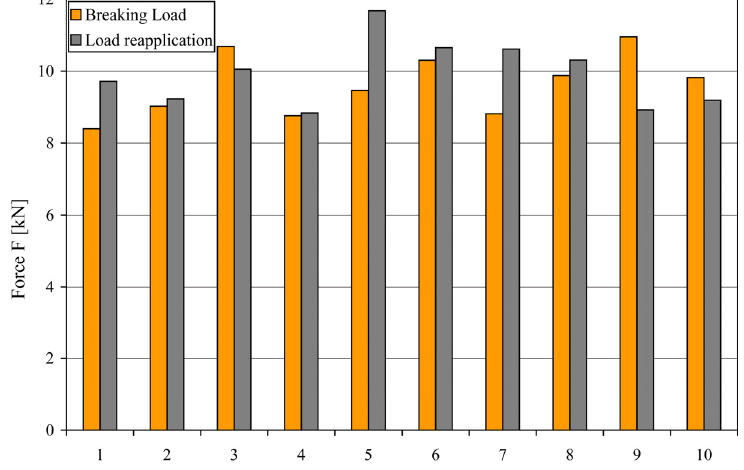
Figure 3: Breaking load and load reapplication of glass-polycarbonate